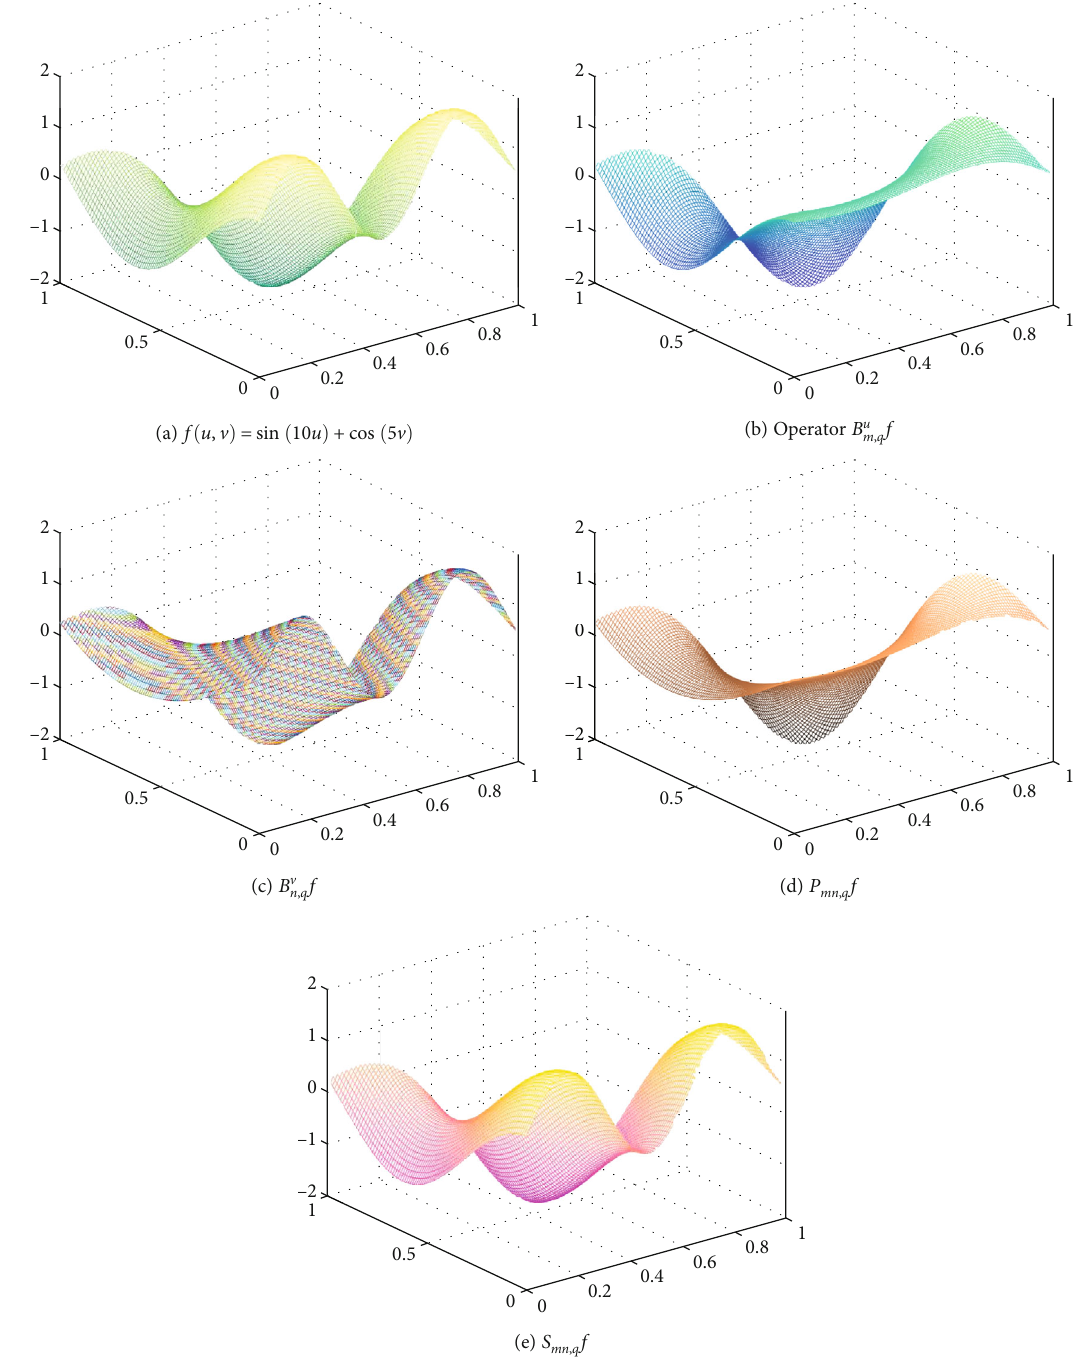
f , B v f , P f , and S f approximating function on triangular domain for h = 1 , m = 6 , n = 6 , and q = 0 : 70 mn , q mn , q m , q n , q